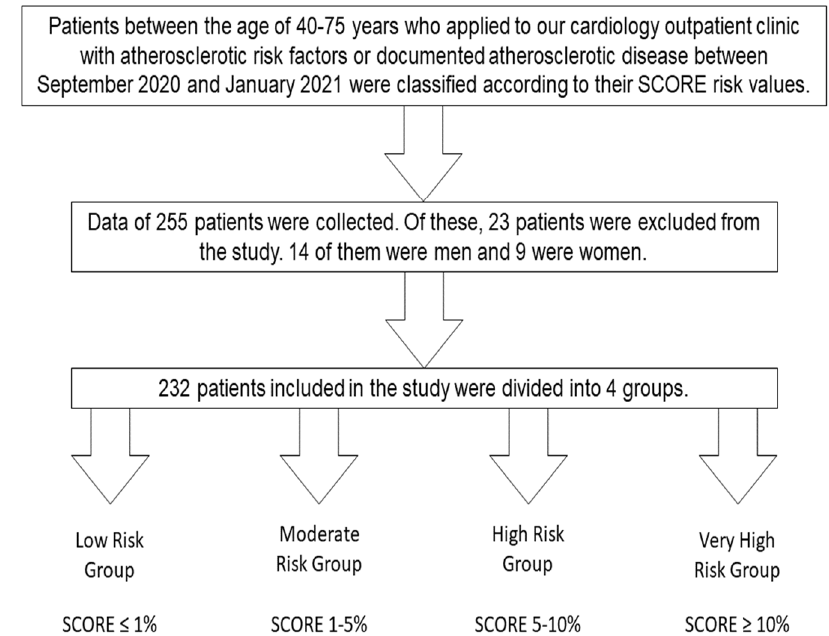
Figure 1. Flow diagram of the study design.